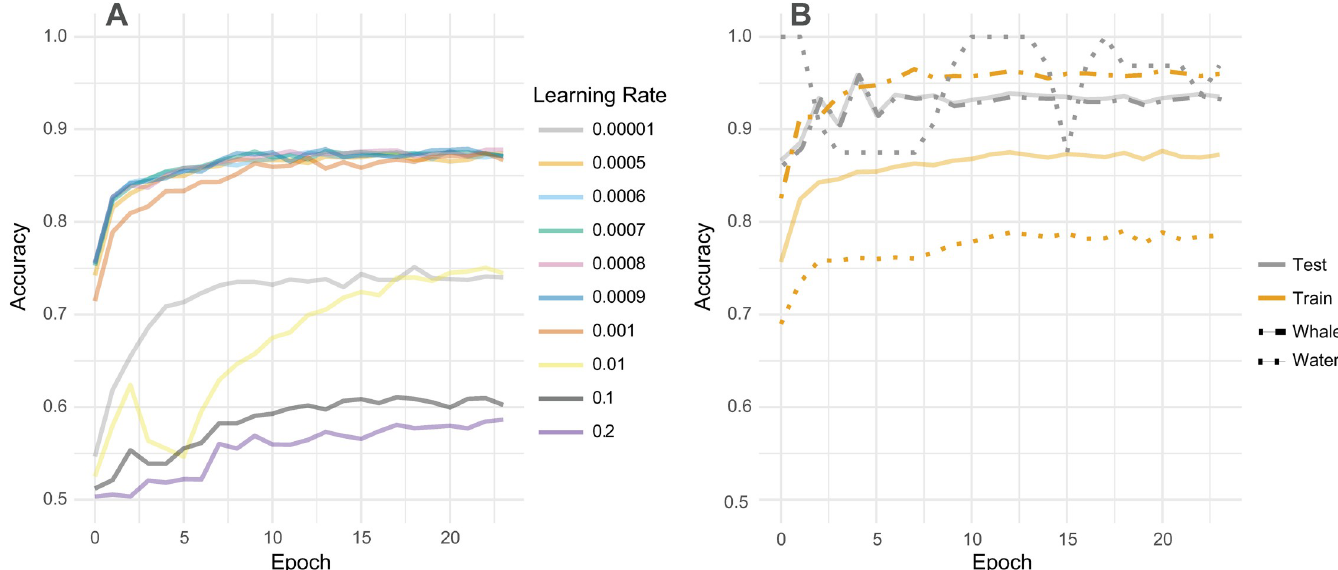
Fig 3. Effect of learning rate on performance. (A) Each model was trained using several different learning rates, which affected their performance on the training dataset (S9 File). (B) The best model weights came from the 12 th epoch of a ResNet-152 model with a learning rate of 0.0006 (S10 File). In both training and testing phases, solid lines show overall performance, while dashed and dotted lines show the accuracy of the individual classes. With a step-size of 7, the learning rate begins to decay at the 7 th epoch, and the accuracy begins to level out.